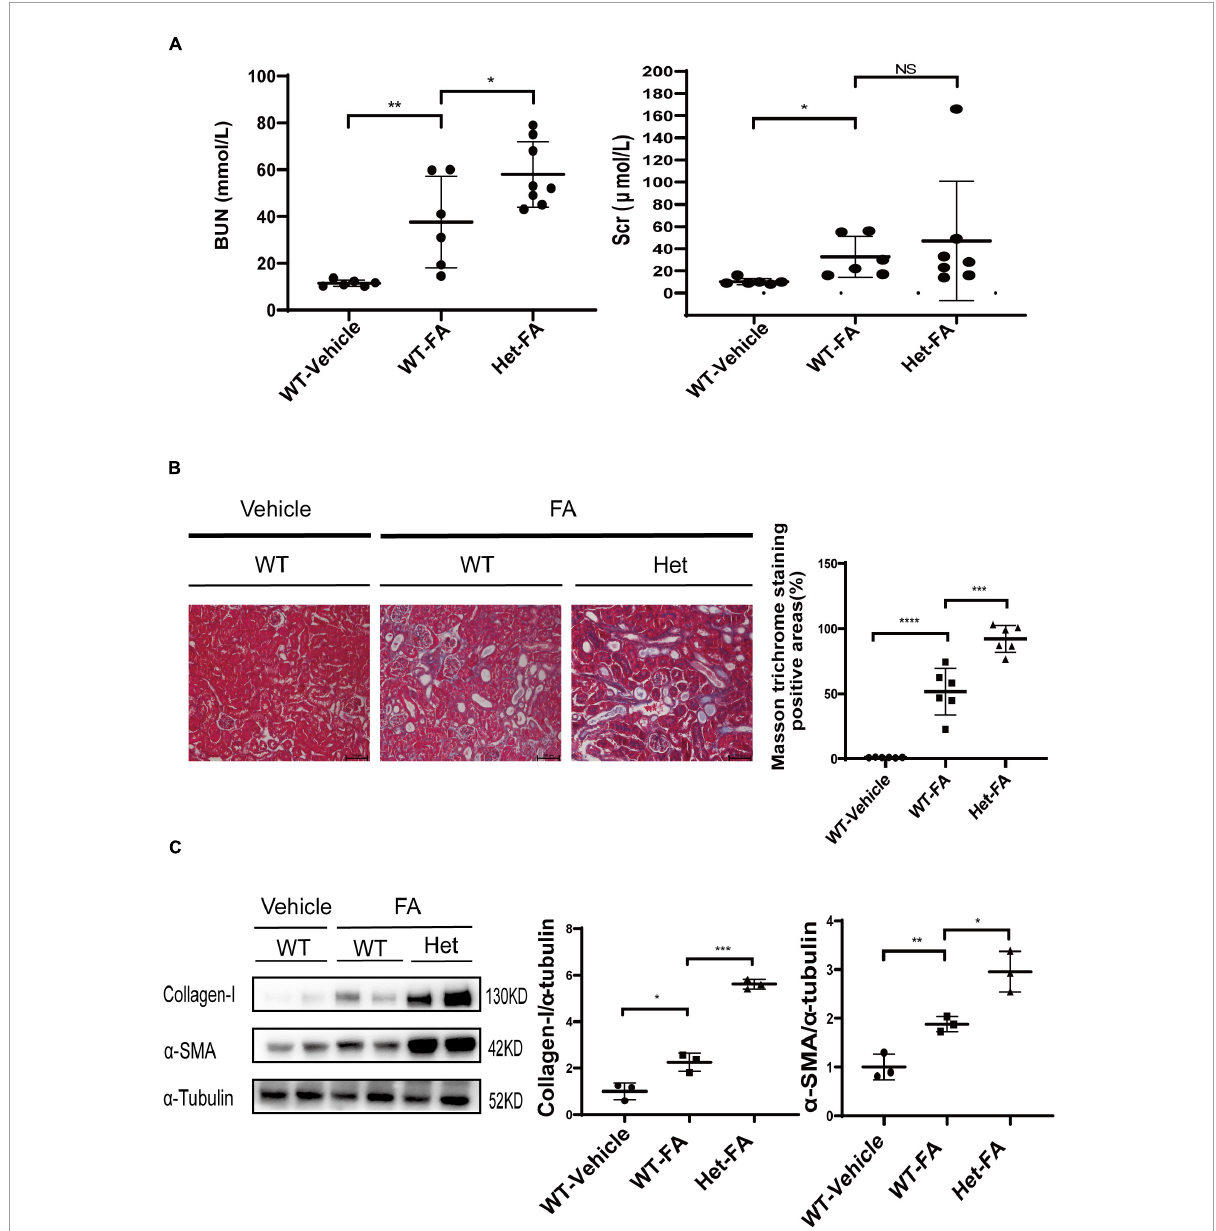
FIGURE4 Heterozygous deletion of Prmt3 exacerbates renal injuries in FA nephropathy. Mouse FA nephropathy was induced by intraperitoneal injection of FA (250 mg/kg in 150 mmol/L sodium carbonate) in WT or Het Prmt3 mutant c57 mice, and mice were sacrificed at 48 h ( n = 6, WT-vehicle; n = 6, WT-FA; n = 8, Het-FA). (A) Renal function (blood urea nitrogen, BUN; serum creatinine, Scr) was assessed. Bars, 100 µ m. (B) Renal fibrosis was assessed by Masson’s trichrome staining ( n = 6 mice per group). (C) The expression of α -SMA and collagen-I were analyzed by Western blotting. One representative of at least three independent experiments is shown. Data represent mean ± SD. One-way ANOVA was used and comparison between two groups was performed by unpaired student t -test. NS represent not significant; * P < 0.05; ** P < 0.01; *** P < 0.001; **** P < 0.0001. One representative result of at least three independent experiments is